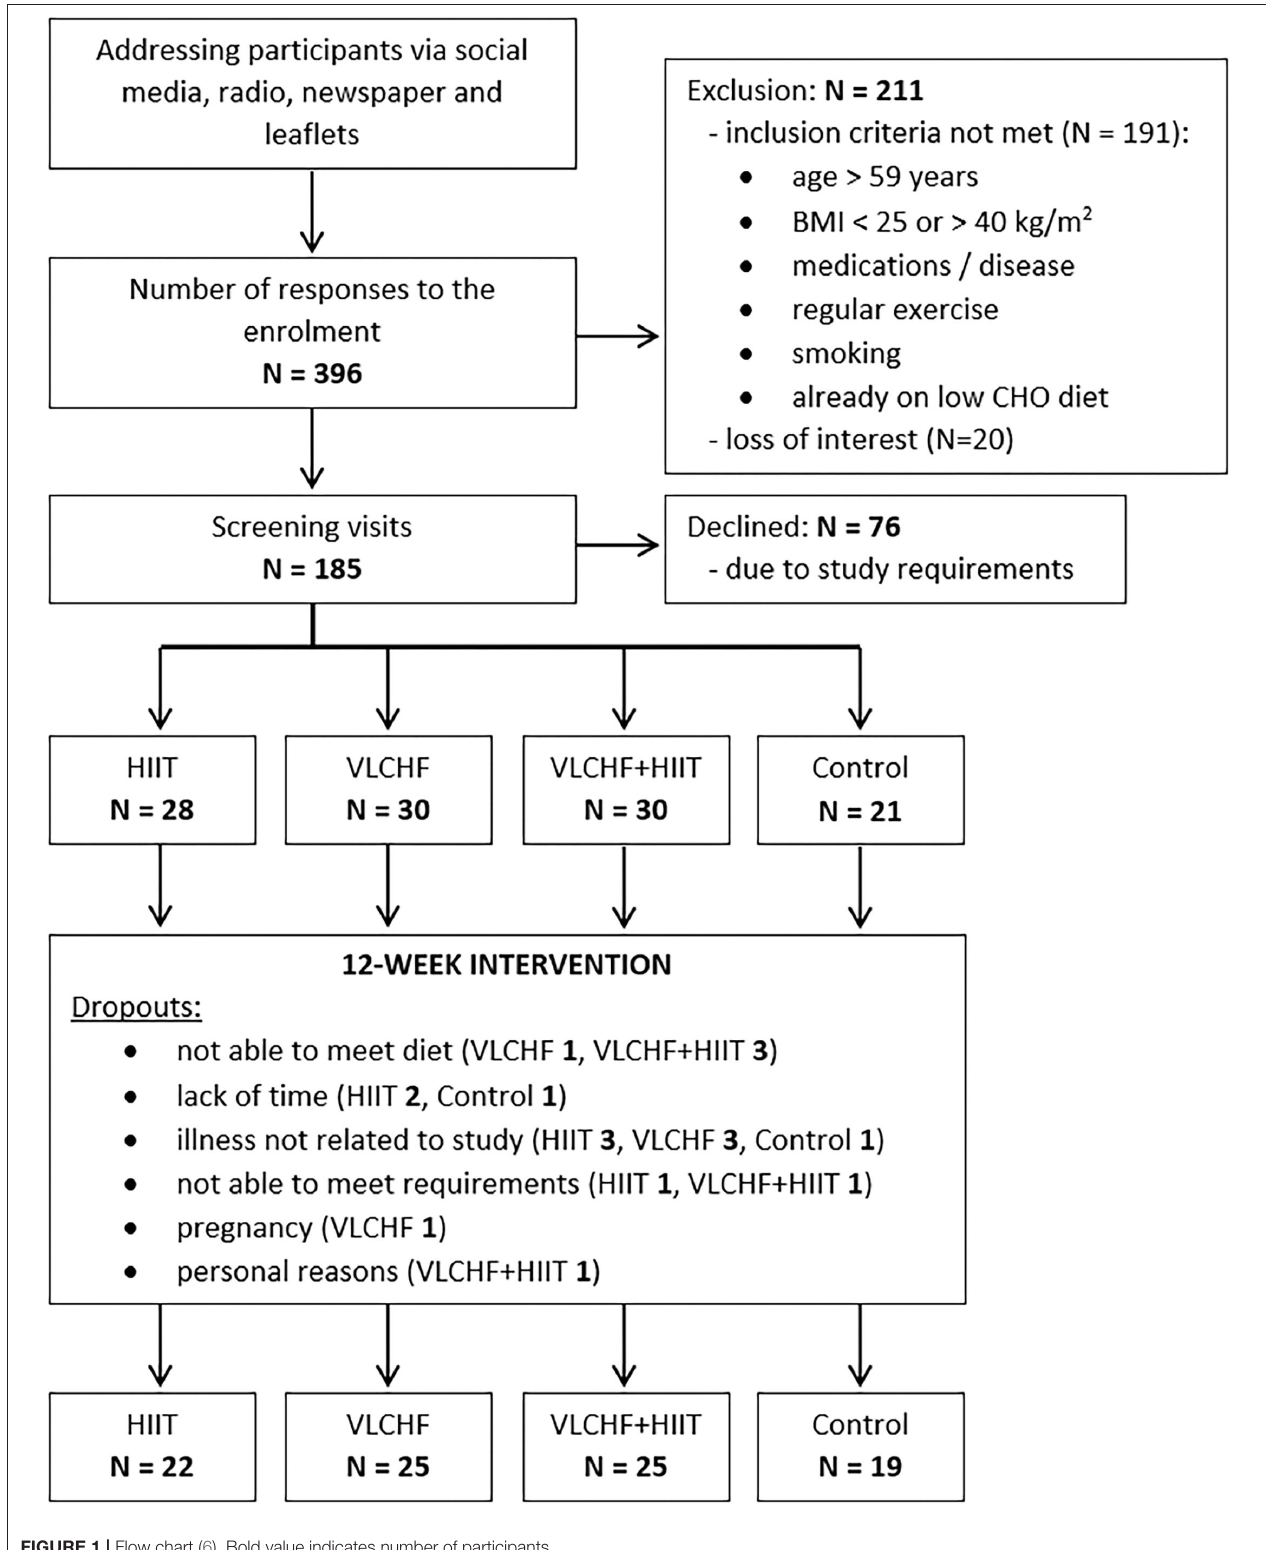
FIGURE 1 | Flow chart (6). Bold value indicates number of participants.